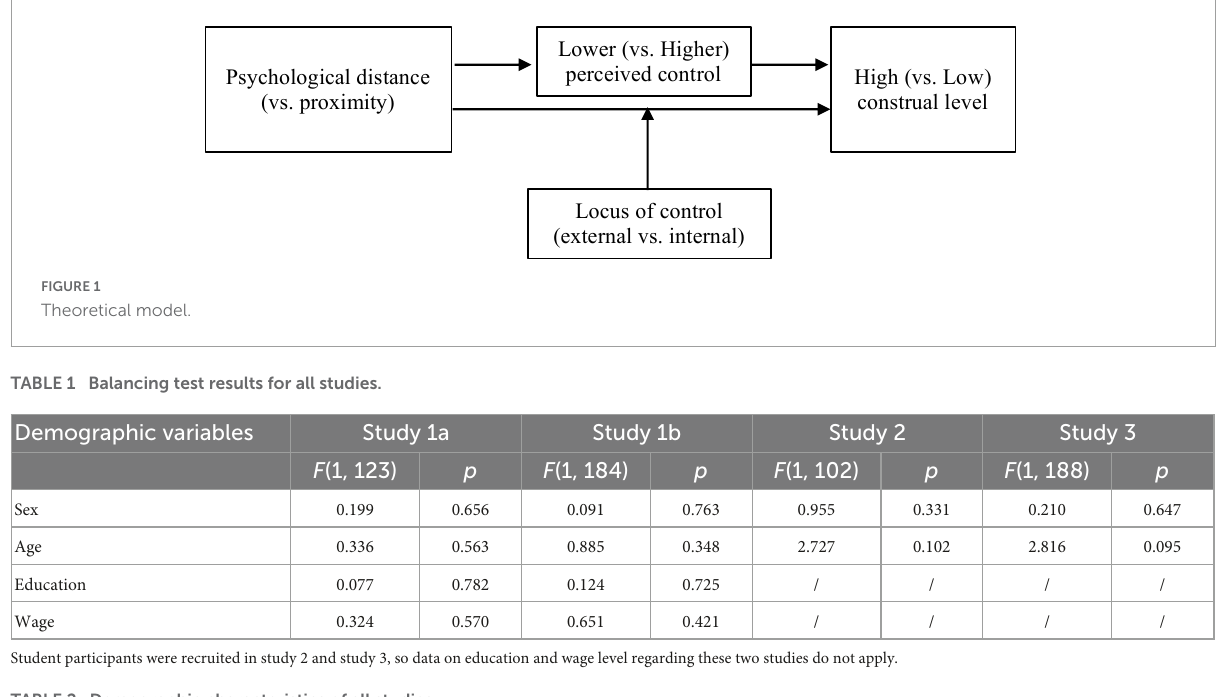
TABLE 2 Demographic characteristics of all